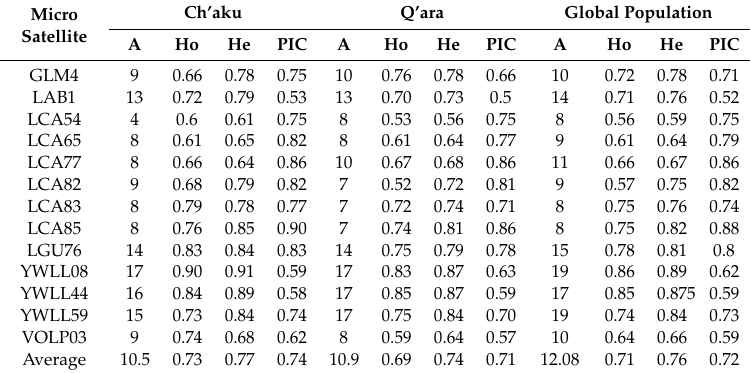
Table 1. Genetic diversity parameters of each llama subpopulation and the global